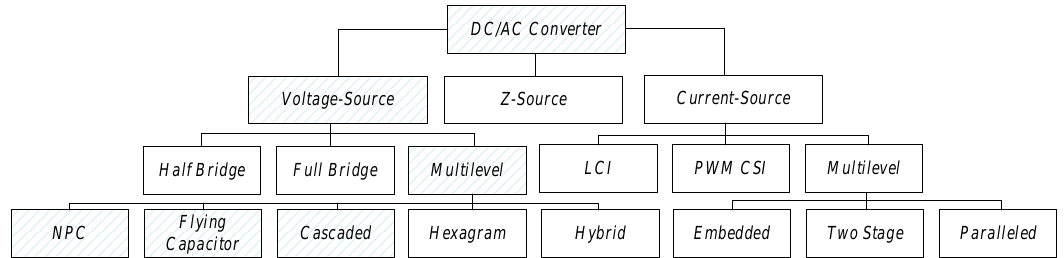
Figure 2. Multilevel inverters classification presented in [32].